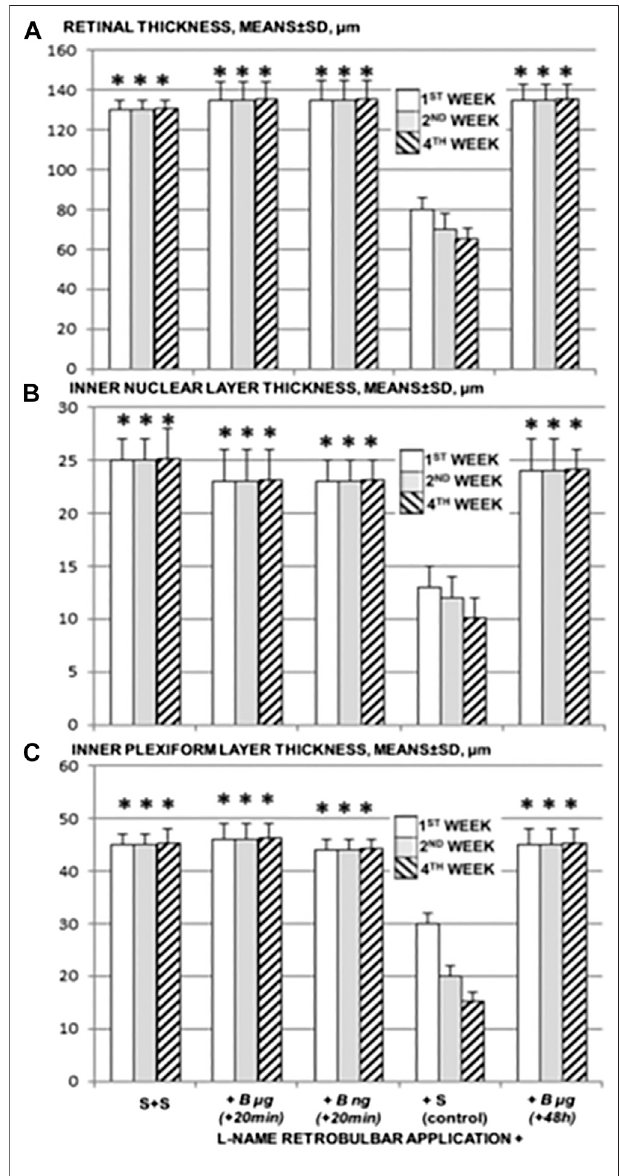
FIGURE 6 | Retrobulbar L-NAME application – induced retinal damage. Retinal thickness (A) , inner nuclear layer thickness (B) , and inner plexiform layer thickness (C) presentation after retrobulbar agent ’ s application. Left. Saline retrobulbar application(s) completely preserved retinal thickness (S+S).Right.L-NAMEretrobulbarapplication(totaldose5 mg/kg,whichwas divided by retrobulbar application in each eye, 0.5 mg/0.1 ml